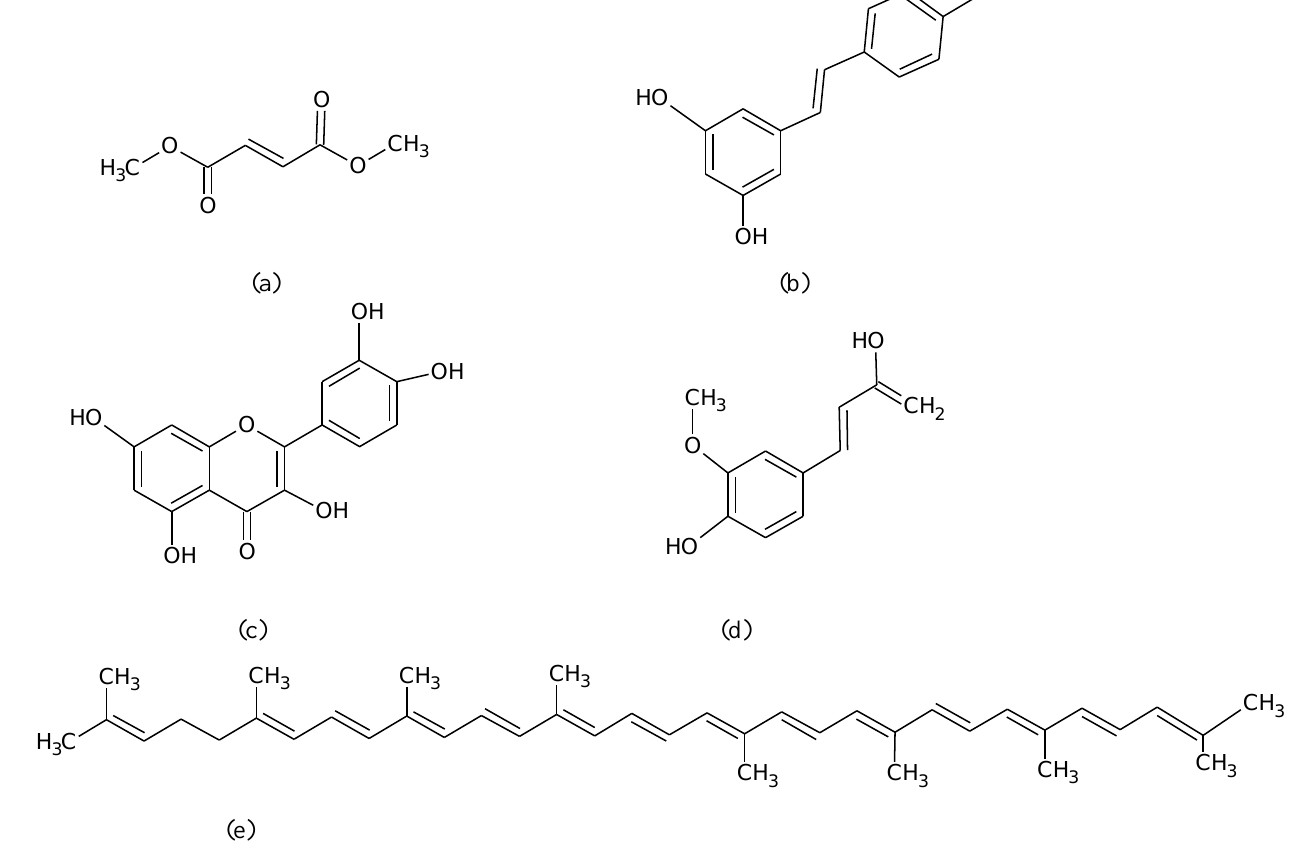
Figure 11. Chemical formula of ( a ) Dimethyl fumarate (DMF), ( b ) resveratrol, ( c ) quercetin, ( d ) ferulic and ( e ) lycopene.